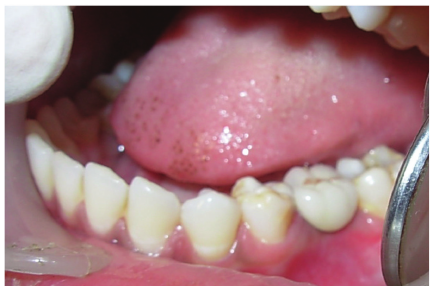
Figure 10: Clinical view of the final restoration at 12 months after